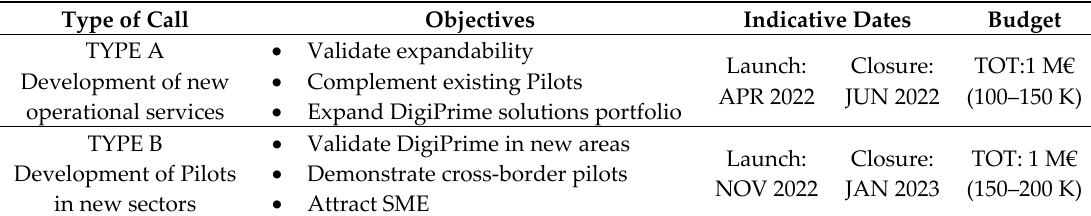
Table 1. DigiPrime competitive Open